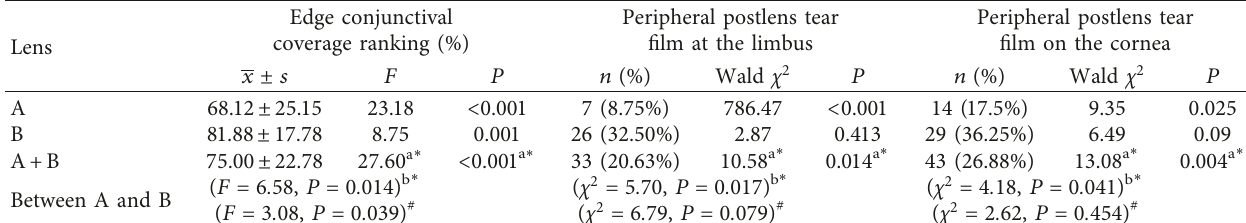
Table 2: Conjunctival response and peripheral PoLTF for two lenses during lens daily wear. Lens